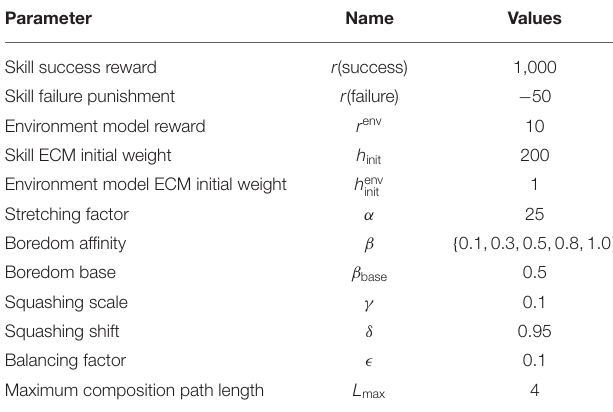
TABLE 1 | List of free parameters and values